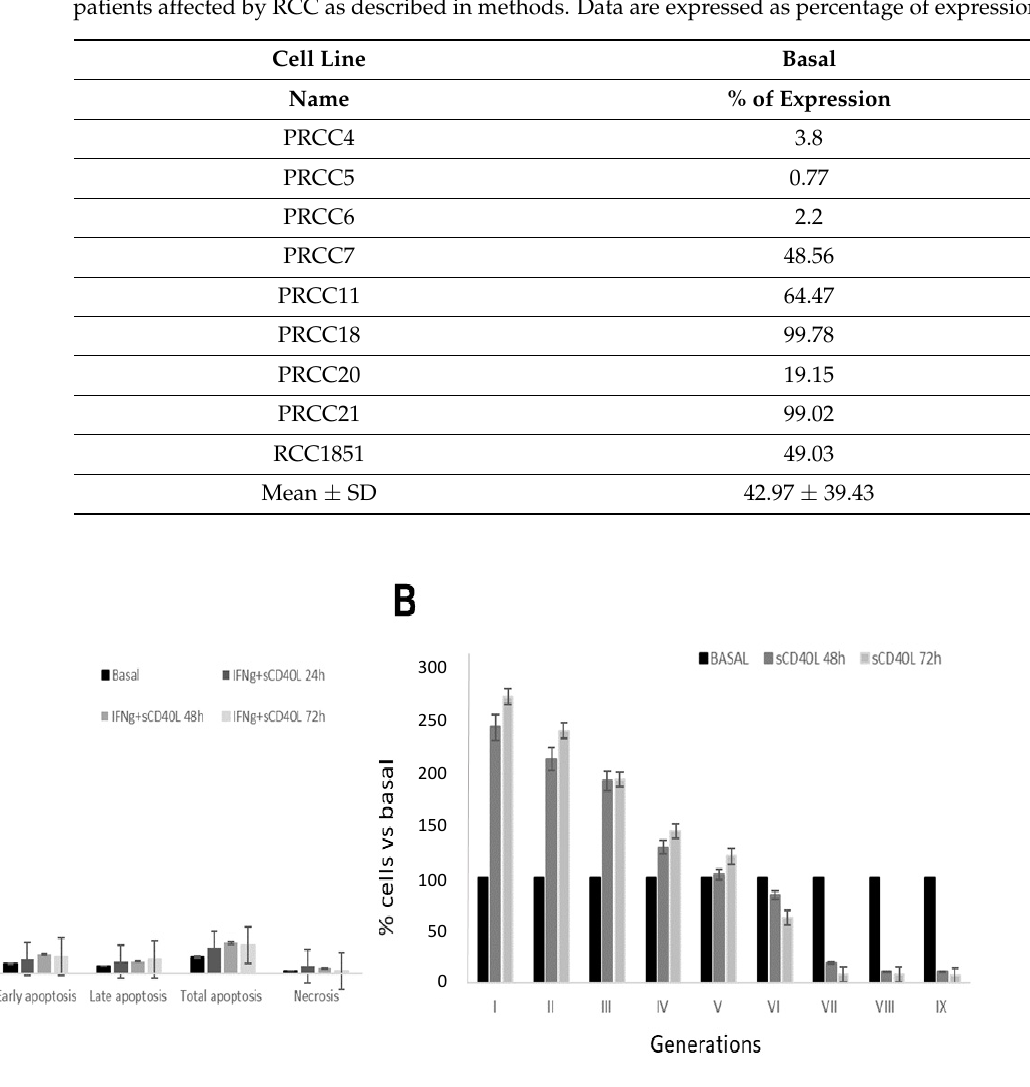
Figure 1. Effect of CD40 ligation on cell apoptosis ( A ) and cell proliferation ( B ) in RCC cell lines. ( A ) RCC cells were preincubated for 24 h with 500 UI/mL IFN- γ and then stimulated with sCD40L and sCD40L enhancer for 24, 48 and 72 h. Cells were analyzed by flow cytometry after staining with Annexin V-FITC and 7-AAD. Results were expressed as percentage of each distinct population (alive cells, apoptotic cells -early, late and total- and necrotic cells) versus the total cell number. The figure is representative of three experiments on three different RCC lines and there is no statistically significant difference over the conditions. ( B ) RCC cells were pre-incubated with 5 µ M CFSE for 48 h, then pre-incubated for 24 h with 500 UI/mL IFN γ and stimulated with sCD40L and sCD40L enhancer. CFSE was detected in FL1 with a logarithmic amplifier. The figure is representative of three experiments on three different RCC